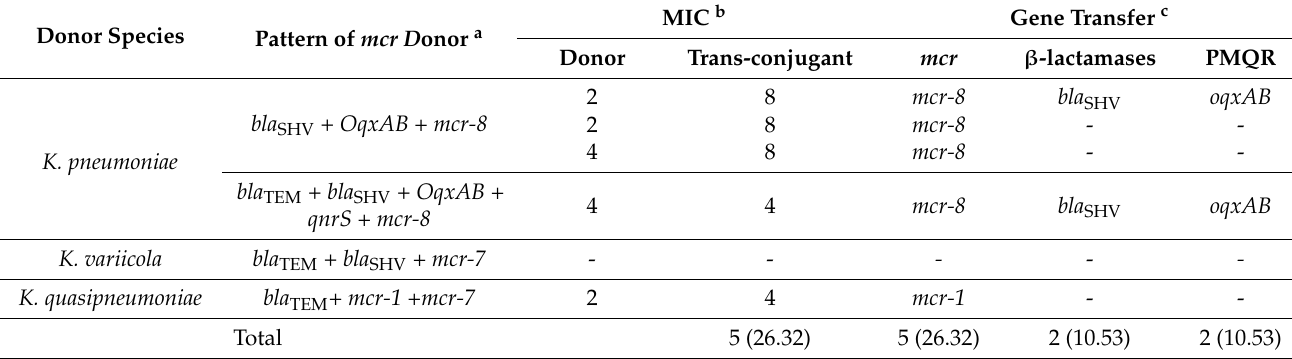
a Pattern of antimicrobial resistance genes in KpnC donor strains. b MIC values of colistin in KpnC donor and tranconjugant strains. c Profile of antimicrobial-resistance genes ( mcr , β -lactamases, and PMQR) in tranconjugants. Abbreviations: +, co-existence of antimicrobial- resistance genes; -, not